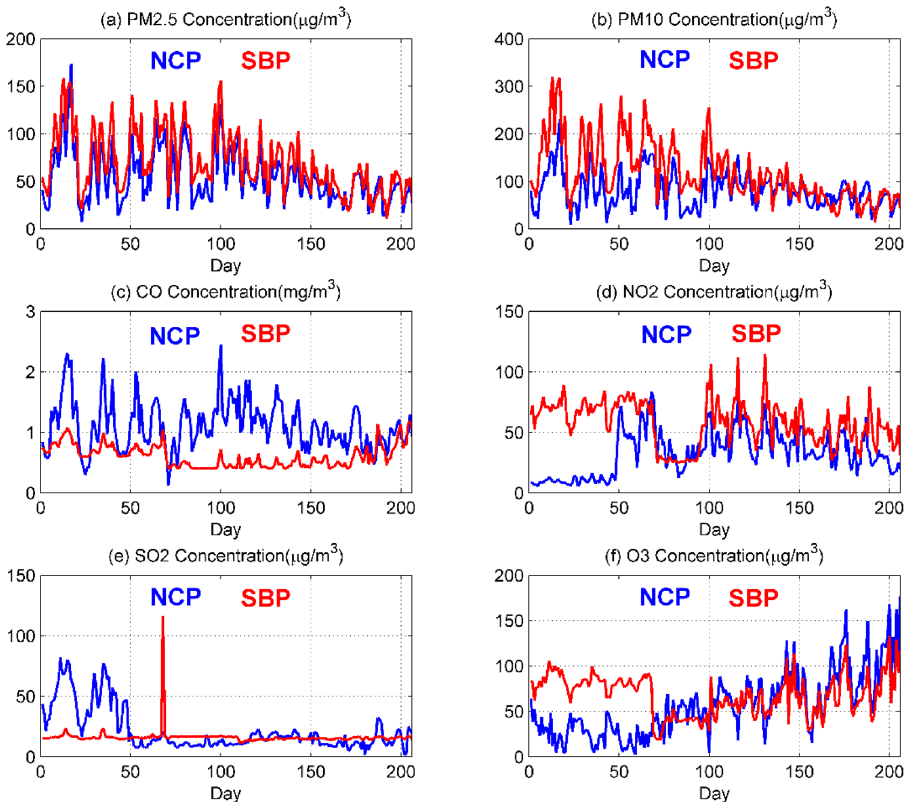
Figure 1. Comparison of daily average data of six types of pollutants at national control point (NCP) and self-built point (SBP). Figures are generated using Matlab (Version R2016a, https:// www. mathw orks. com/)